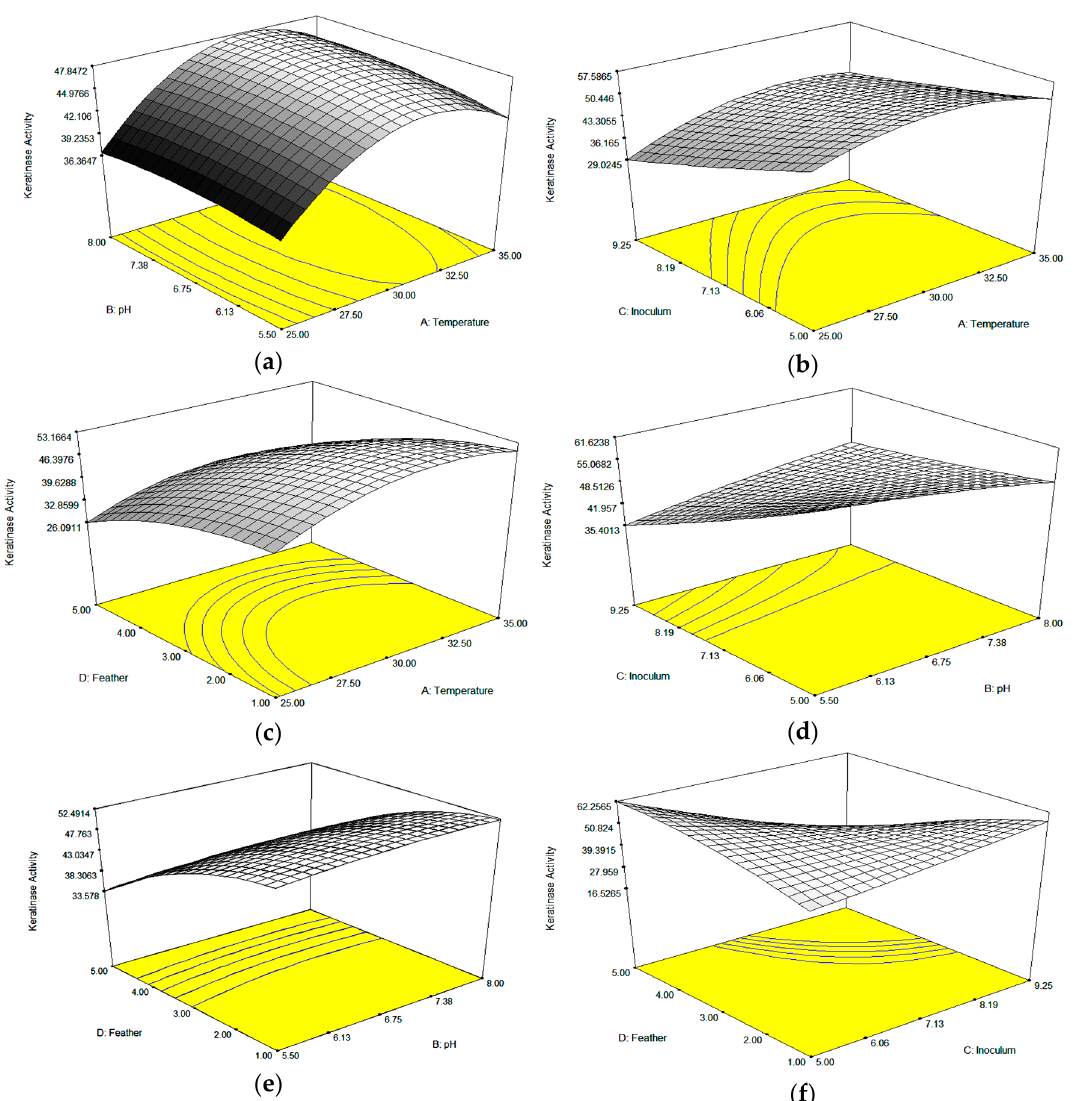
Figure 3. Response surface 3D plot showing the interaction of factors affecting keratinase production ( a ) pH and temperature, ( b ) inoculum size and temperature, ( c ) feather concentration and temperature, ( d ) pH and inoculum size, ( e ) pH and feather concentration, and ( f ) feather concentration and inoculum size.